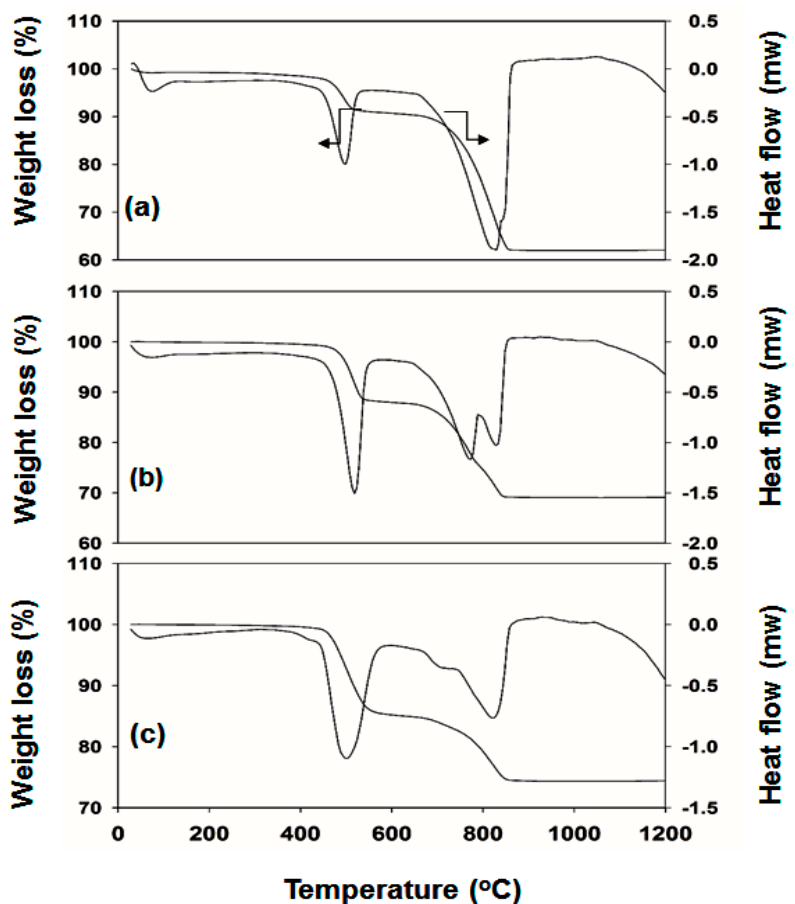
Figure 4. TGA / DSC profiles obtained from the ( a ) LC-1, ( b ) LC-2, and ( c ) LC-3 as-synthesized products. TGA/DSC curves obtained at a heating rate of 10 °C min –1 in air.